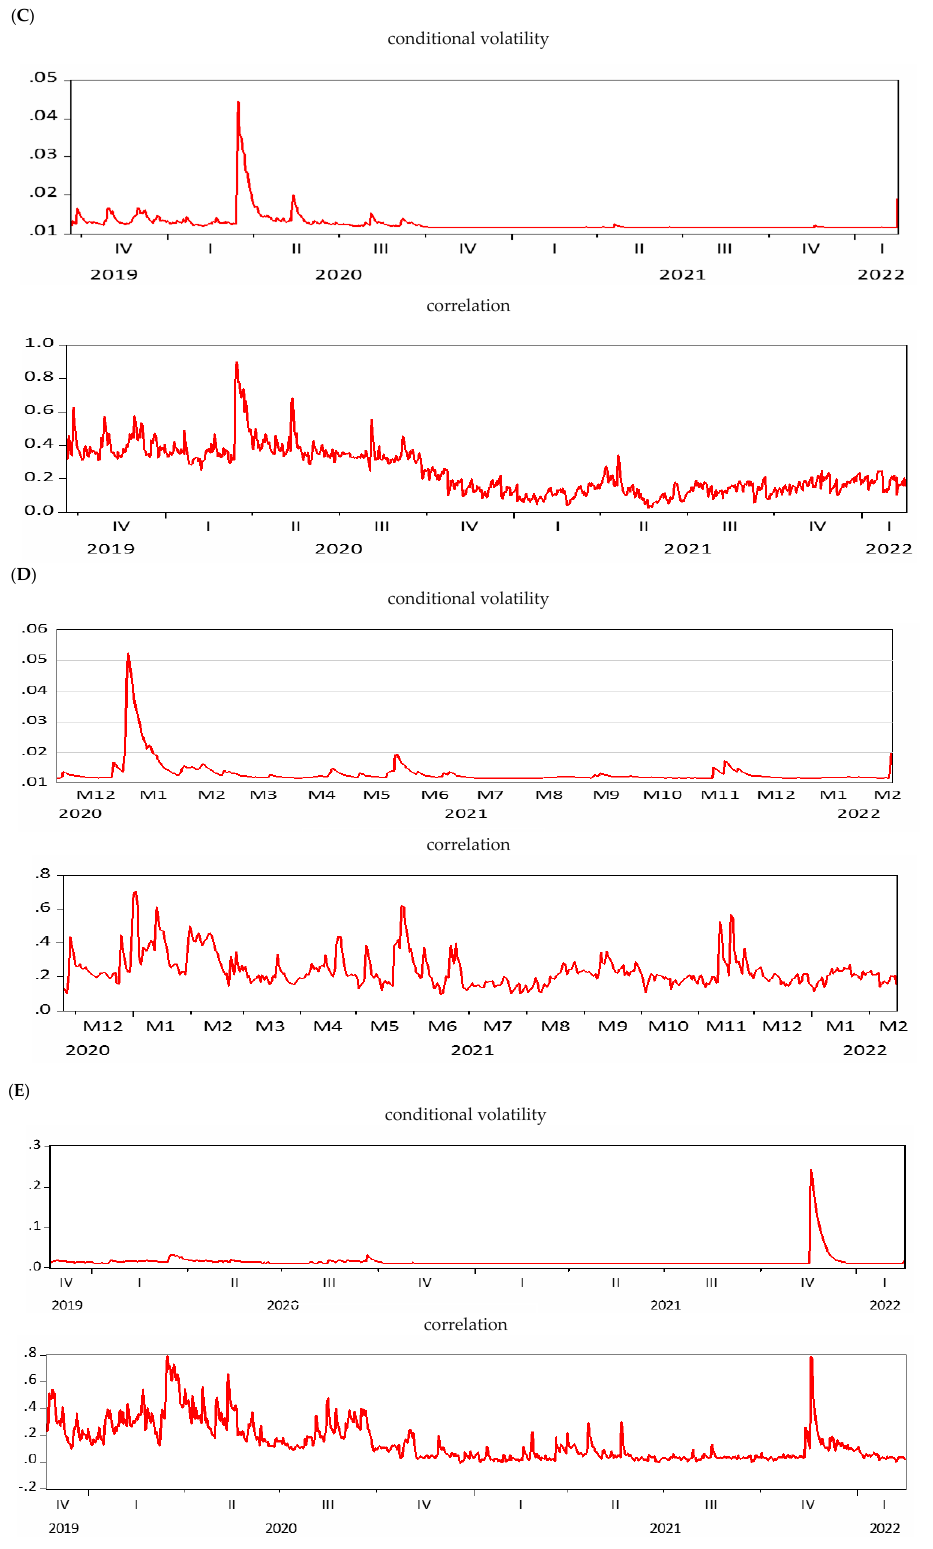
Figure 4. Conditional volatility and correlation between Bitcoin and stablecoins (Copula–DCC– GARCH model). ( A ) Bitcoin vs. Tether. ( B ) Bitcoin vs. USD Coin. ( C ) Bitcoin vs. Binance USD. ( D ) Bitcoin vs. Terra USD. ( E ) Bitcoin vs. Dai. Notes: As plotted in Figure 4 the upper, and bottom panels denote conditional volatility and correlation series, respectively. Table 5. VAR Granger causality tests for BTC and stablecoins.